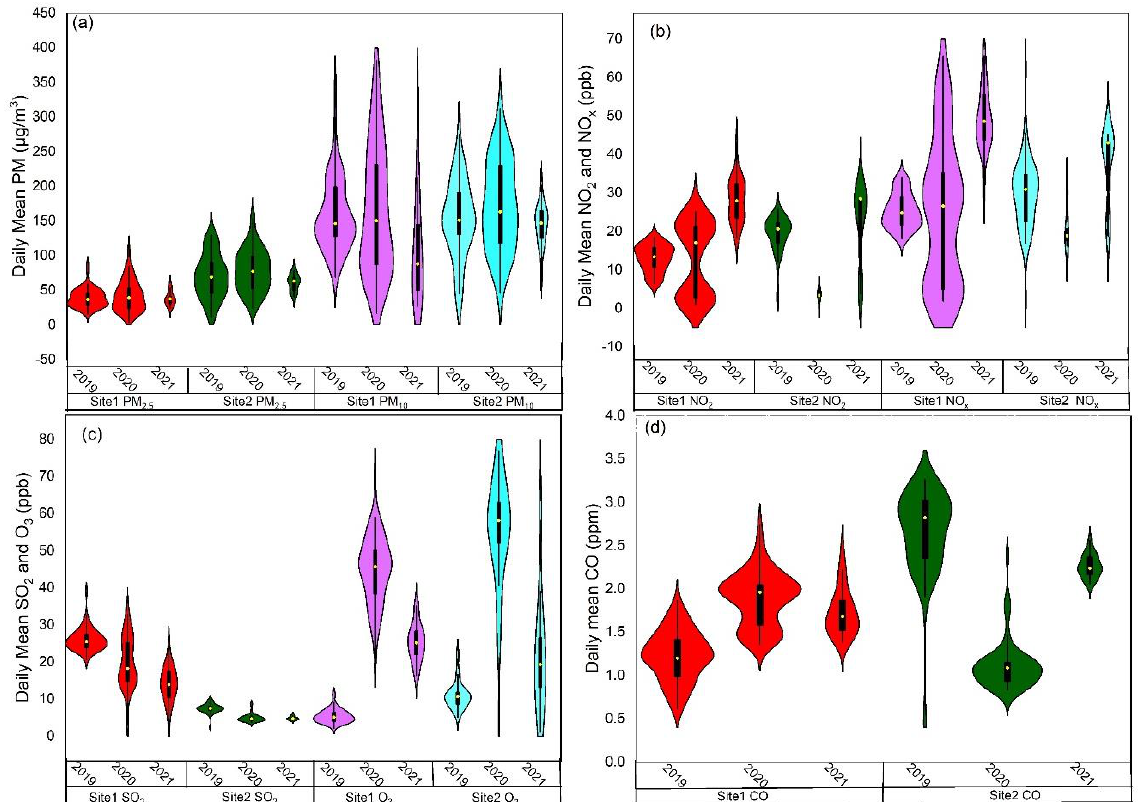
Figure 6. Violin plots of pollutant variations during LD2020, LD2021, and pre-lockdown year 2019 for site #1 and site #2 (thick black bar: interquartile range, central yellow dot: median, whiskers: ±1.5 × interquartile range). ( a ) Daily mean of PM, ( b ) Daily mean of NO 2 and NO x , ( c ) Daily mean of SO 2 and O 3 and ( d ) Daily mean of CO.